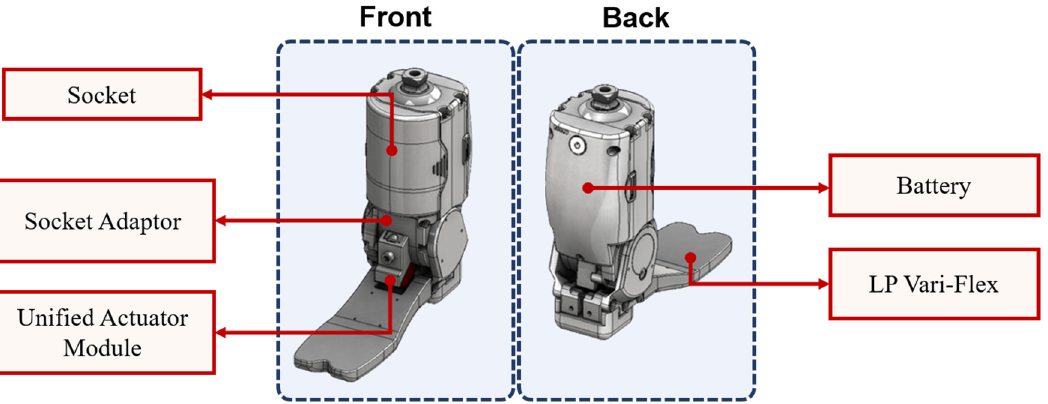
Figure 1. The Blueprint of the Robotic Ankle Prosthetic Leg (Socket = A part that holds the patient’s amputation site. Socket Adaptor = It is a part that aligns the socket when working on the prosthesis. Unified Actuator Module = A module that performs ankle movements. Battery = A part that recharges the prosthesis. LP Vari ‐ Flex = The LP Vari ‐ Flex is a module for users with long cut edges that do not have enough free space for the Vari ‐ Flex) (Source: Hugo Dynamics, Product: RoFT(gen.2), Model: HGROFT02).